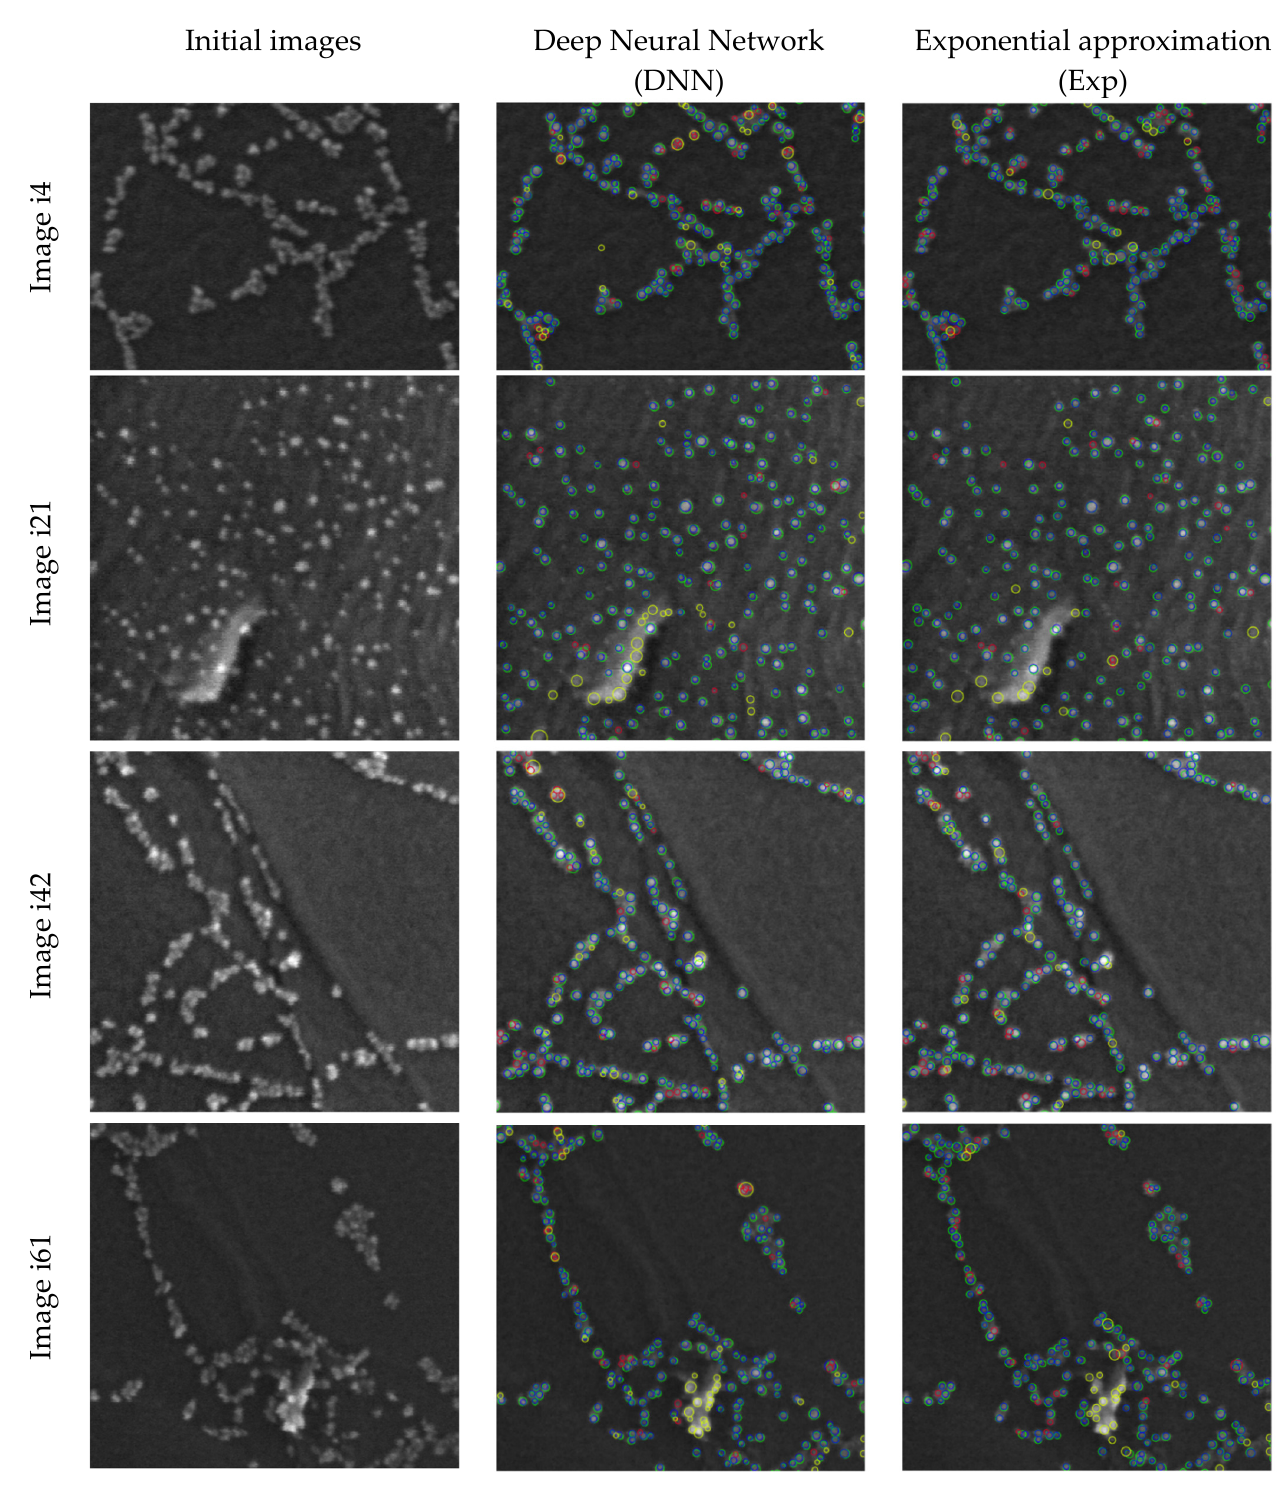
Figure 1. Visualization of the results of nanoparticle detection for the DNN and Exp